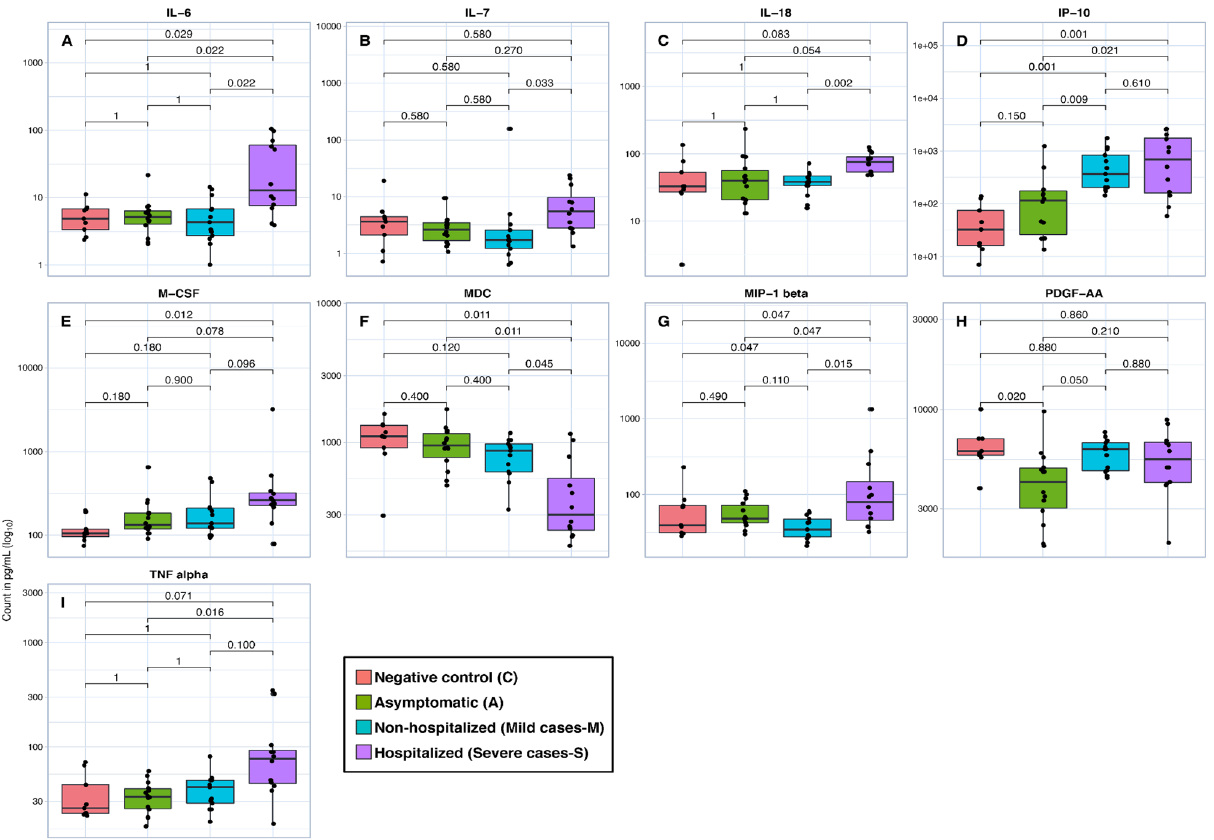
1. Box plot representation of the serum concentration (pg/mL) of cytokines/chemokines. Levels of IL-6 ( A ), IL-7 ( B ), IL-18 ( E ), IP-10 ( G ), M-CSF ( H ), MDC ( I ), MIP-1 beta ( K ), PDGF-AA ( L ), and TNF alpha ( M ). The top and bottom lines of boxes are the 25th and 75th percentiles, respectively, and the band in the middle of the box is the median. analysis. Statistical analysis was performed using the Mann–Whitney U test between the negative control (C), asymptomatic (A), nonhospitalized (mild cases-M), and hospitalized (severe cases-S)